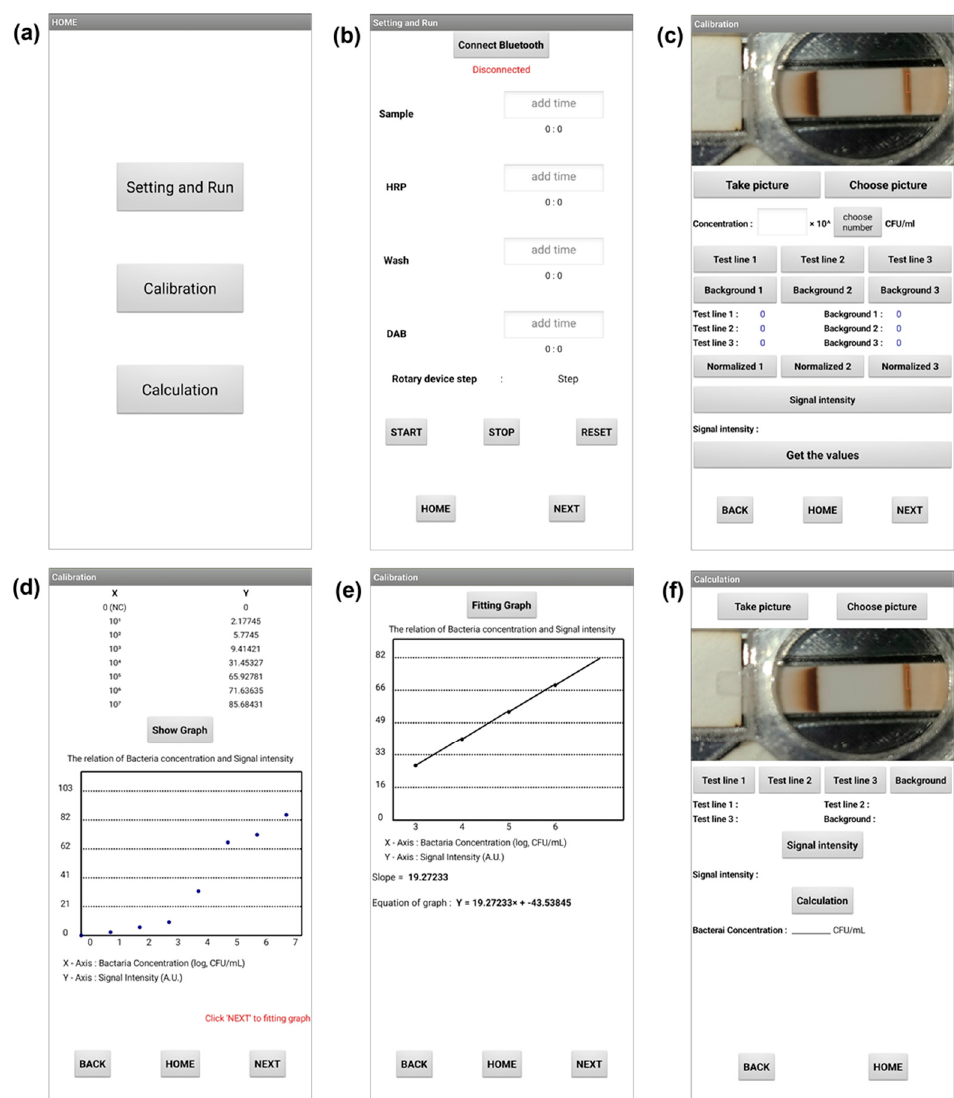
Figure 2. Screenshots of the application for lateral flow immunoassay. ( a ) First page of the application; the user can select the Setting and Run, Calibration, and Calculation menus. ( b ) Screen shot of the Setting and Run, which is a page used for inputting flow durations. ( c ) First page of the Calibration screen, showing the image of the NC strip, and the user can specify the known concentration. ( d ) Calibration curve. ( e ) Linear fit curve showing the slope and the equation of the curve. ( f ) Screen shot of the Calculation, showing the image of the test result of an unknown sample, and the calculated bacteria concentration based on the calibration curve.